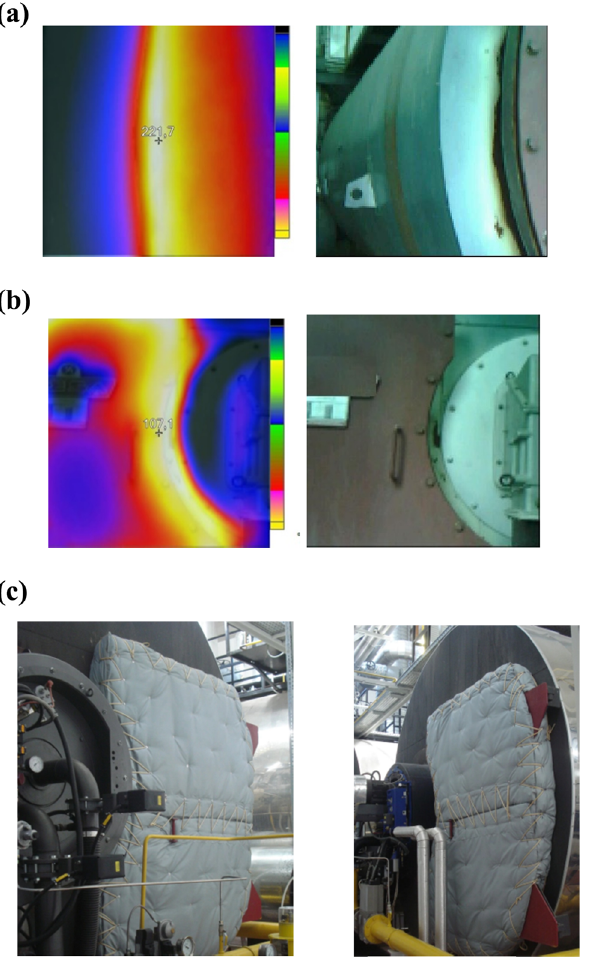
Figure 5: ( a ) Side surface of the back cover ( 214°C ) , ( b ) front surface of the back cover ( 141°C ) , and ( c ) recommended insulation pad for the back